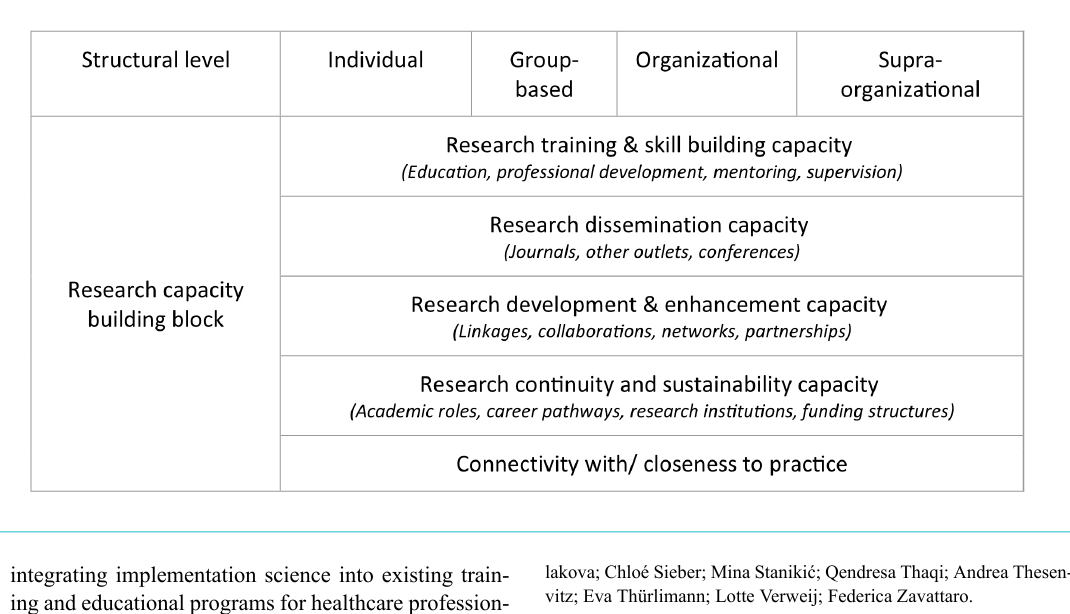
Figure 2: The building blocks of research capacity (adapted based on Cooke J. A framework to evaluate research capacity building in health care. BMC Fam Pract. 2005;6(1):44